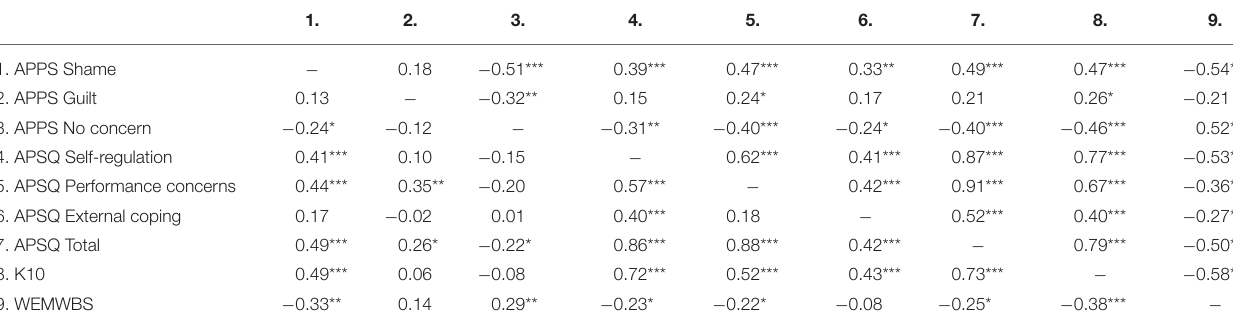
TABLE 4 | Correlations (Spearman) between constructs and domains by sex.